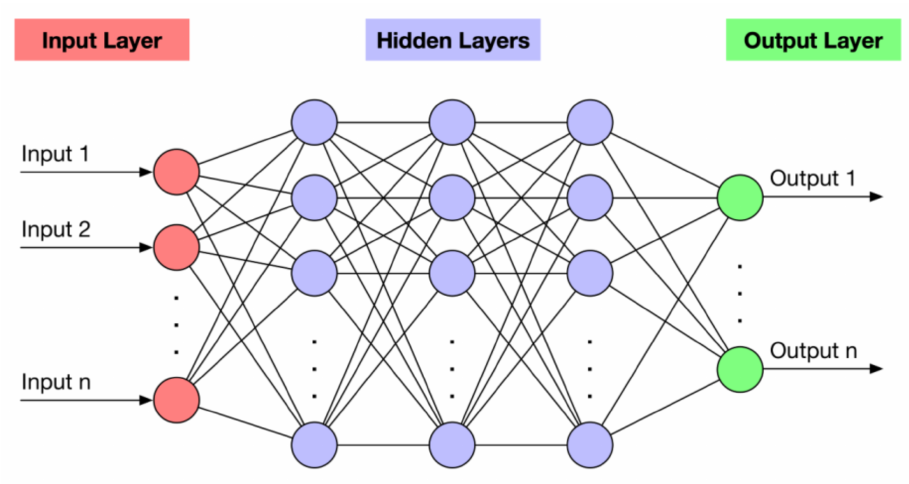
Figure 3. Artificial neural network architecture example.